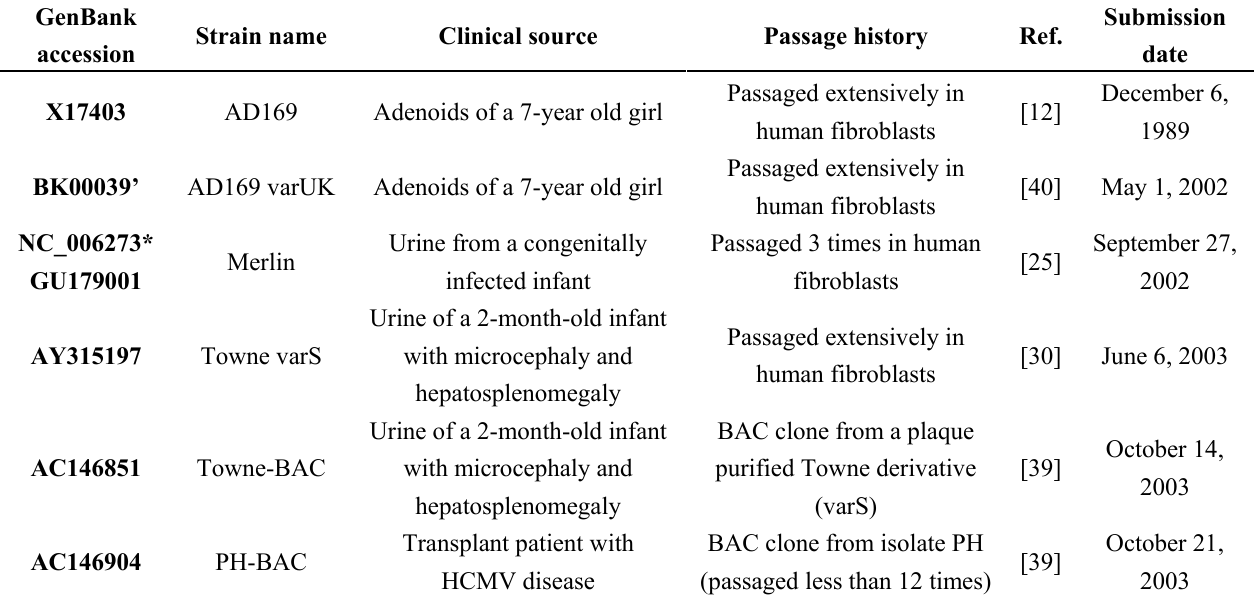
Table 1. HCMV complete genome sequences available on NCBI GenBank, listed in order of submission